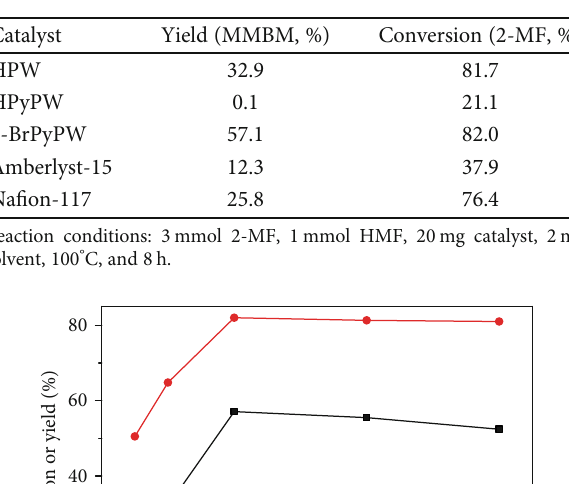
Figure 3: SEM image and elemental mappings of the 3-BrPyPW catalyst. Table 2: Catalytic results for the synthesis of MMBM from 2-MF and HMF over di ff erent catalysts.